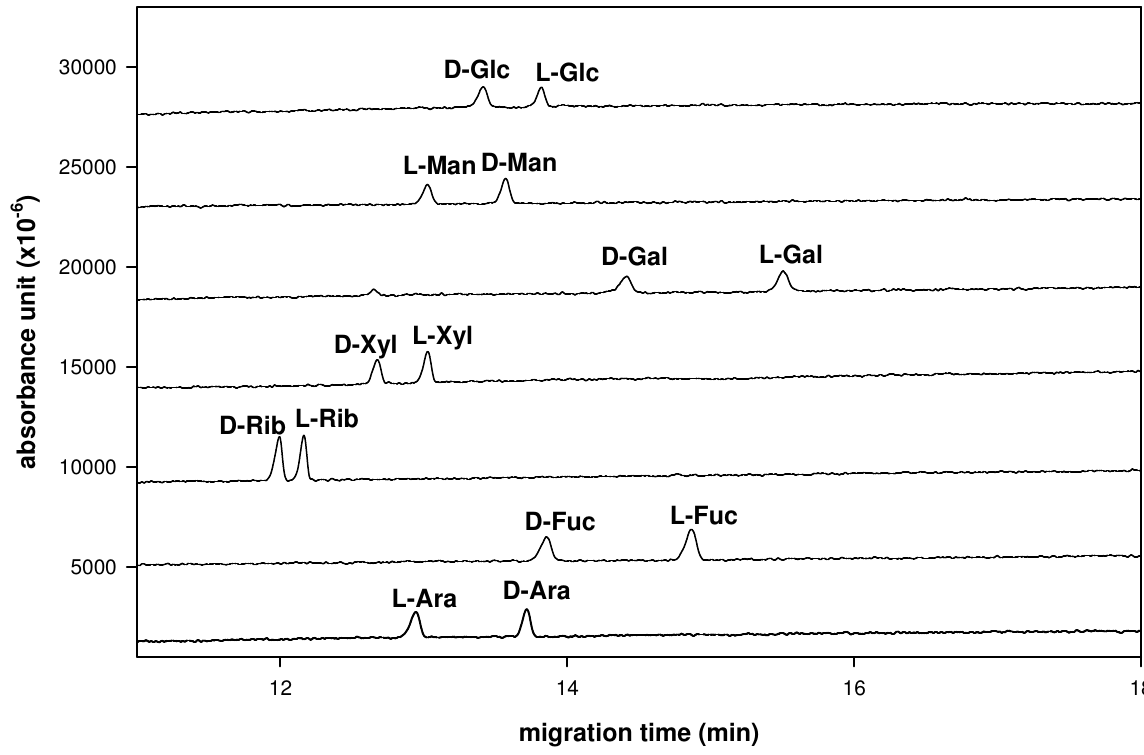
Figure 2. Enantioseparation of seven enantiomeric pairs of indole derivated monosaccharides (aldo-BINs). Conditions: borate buffer (100 mM, pH 9.0) contains hydroxypropyl- β -CD (10 mg/mL); applied voltage, 20 kV (detector at cathode side); uncoated fused-silica capillary, 50 cm (effective length) × 50 µ m I.D.; wavelength, 254 nm; system temperature, 15